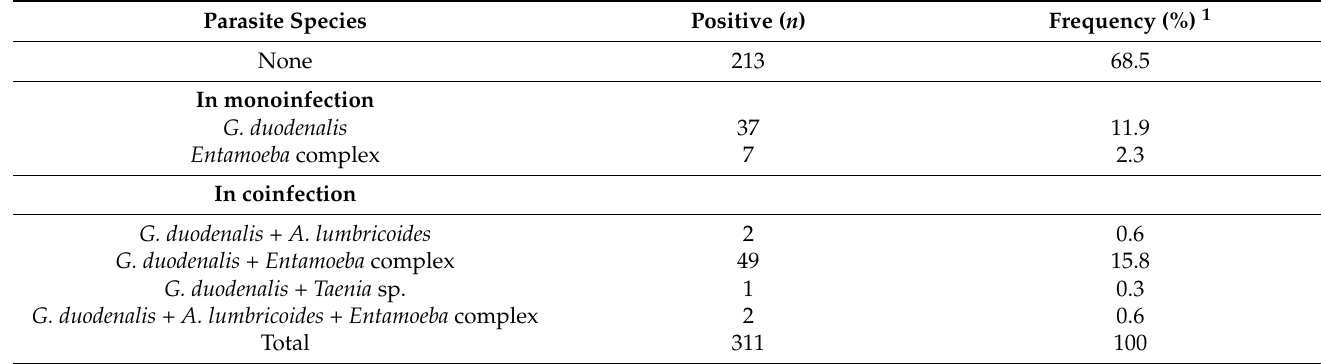
Table 2. Detection of intestinal parasites by microscopy